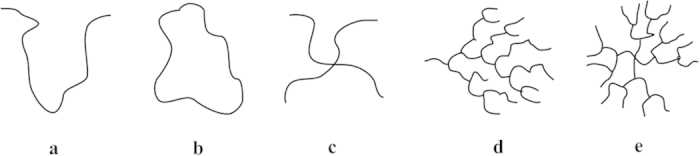
Traditional cartoons of polymers with the following architectures (a) Linear, (b) Ring, (c) Star, (d) Hyper-branched, and (e) Dendrimer.